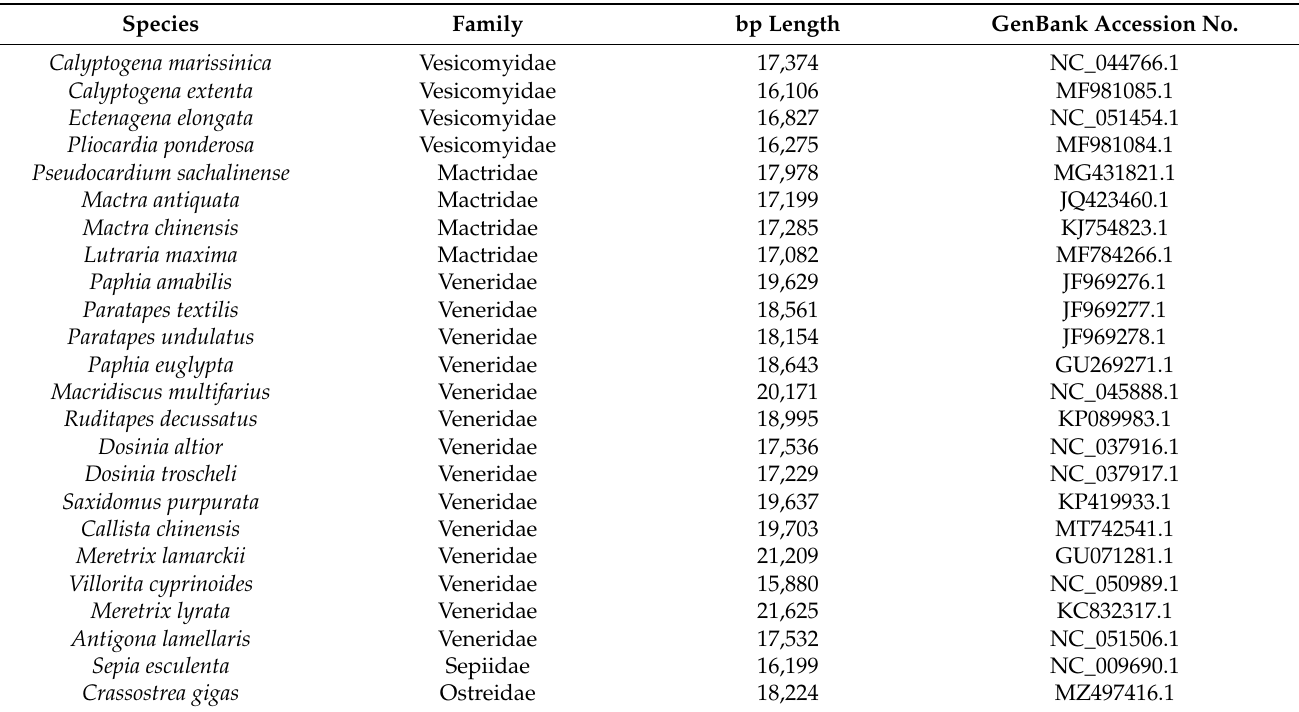
Table 2. List of 24 mollusk species analyzed to construct a phylogenetic tree for Ruditapes philippinarum and R. variegatus with the maximum-likelihood